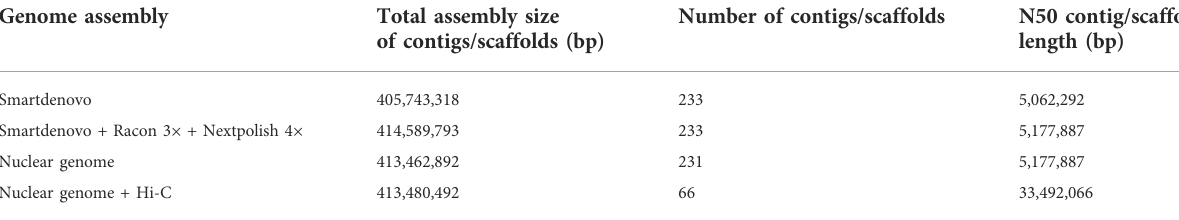
TABLE 1 Genome assembly statistics and post-processing of Dongxiang wild